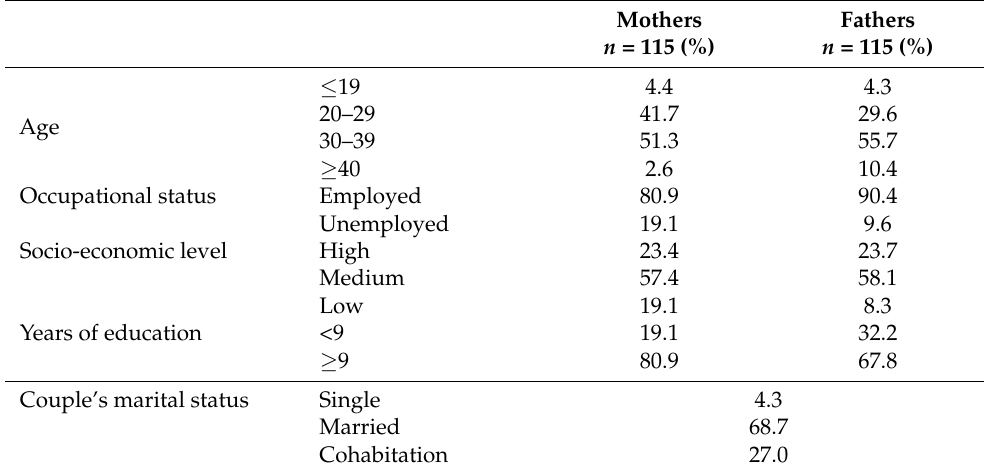
Table 1. Participants’ socio-demographic characteristics.